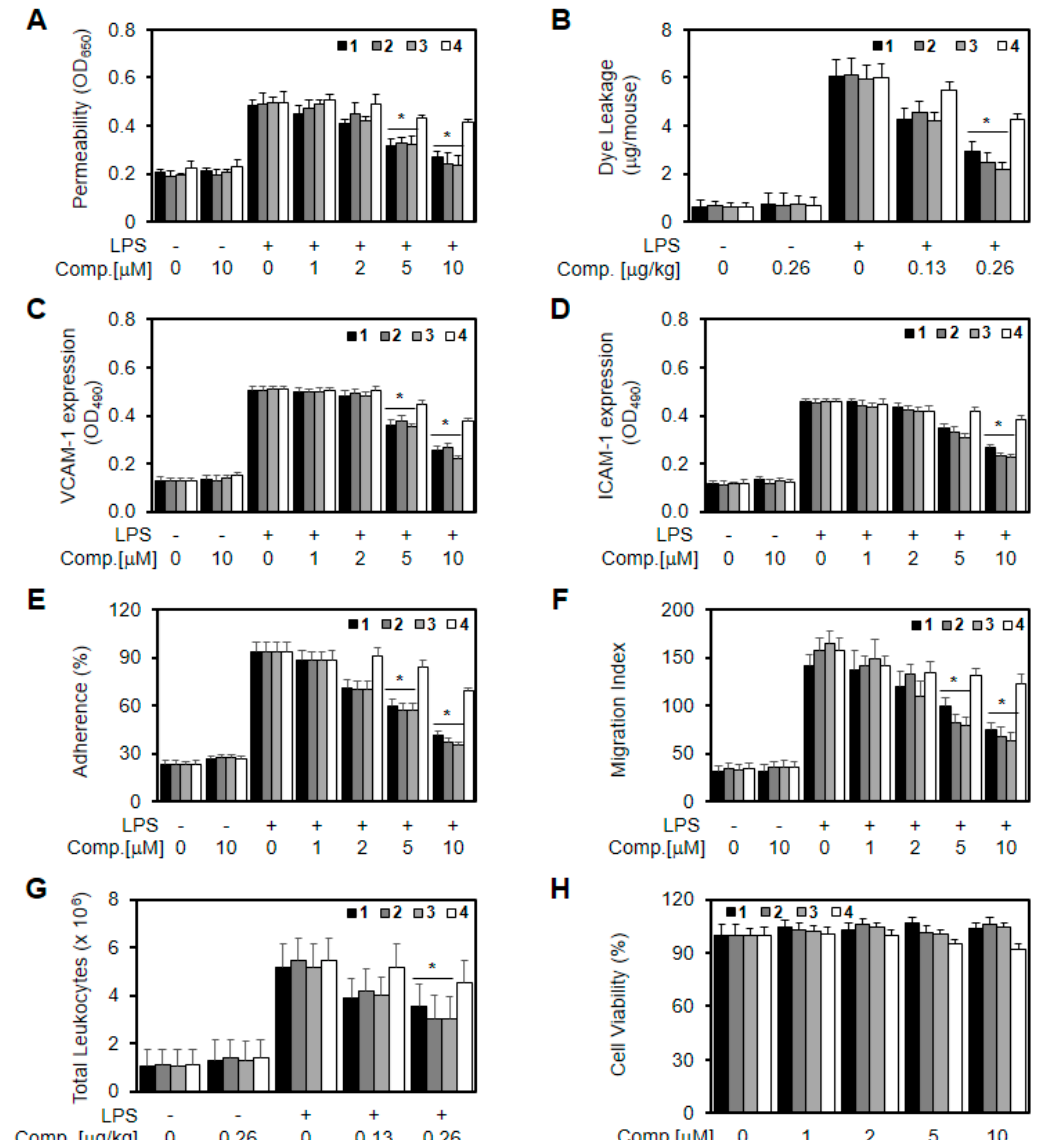
Figure 3. Effects of compounds ( 1 – 4 ) on lipopolysaccharide (LPS)-mediated vascular inflammatory responses. ( A ) Effect of various concentrations of compounds (1–4) on LPS-induced (100 ng/mL, 4 h) barrier disruption was monitored by the flux of Evans blue bound albumin across human umbilical vein endothelial cells (HUVECs); ( B ) Effect of compounds (1–4) on LPS (15 mg/kg, i.p.)-induced vascular permeability in mice was examined by the flux of Evans blue in mice (expressed µg/mouse, n = 5); LPS-mediated (100 ng/mL) expression of vascular cell adhesion molecule-1 (VCAM-1) ( C ) and intercellular adhesion molecule-1 (ICAM-1) ( D ) in HUVECs was analyzed after treating monolayers with each compound (10 µM each) by whole cell enzyme-linked immunosorbent assay (ELISA); ( E ) LPS-mediated (100 ng/mL) adherence of monocytes to HUVEC monolayers was analyzed after treating cells with each compound; ( F ) LPS-mediated (100 ng/mL) migration of human neutrophils through HUVEC monolayers was analyzed after treating cells with each compound; ( G ) The effects of each compound on LPS (15 mg/kg, i.p.)-induced leukocyte migration in mice (expressed ×10 6 , n = 5); ( H ) The effects of each compound on cell viability were evaluated using CCK8 assays. The results are expressed as the means ± SEM of three independent experiments. * p < 0.05 vs. LPS.